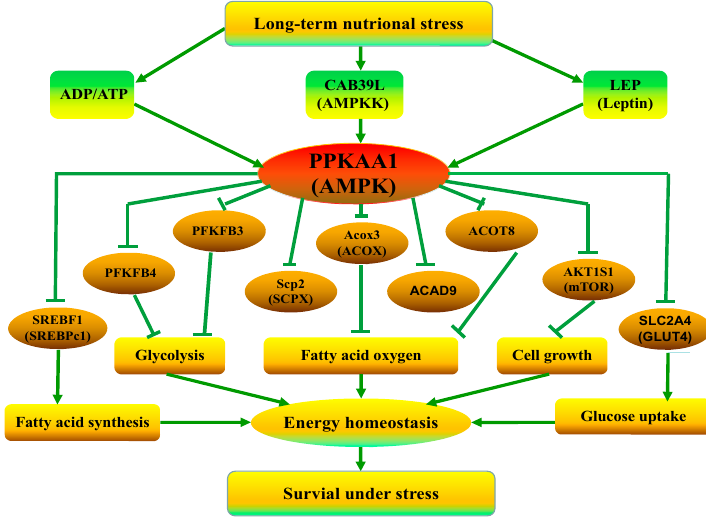
Figure 4. The energy balance in yaks under ES by regulating fat metabolism. → : promote or result in; ┴ : repress gene expression, diminish metabolic pathway or inhibit physiological process.